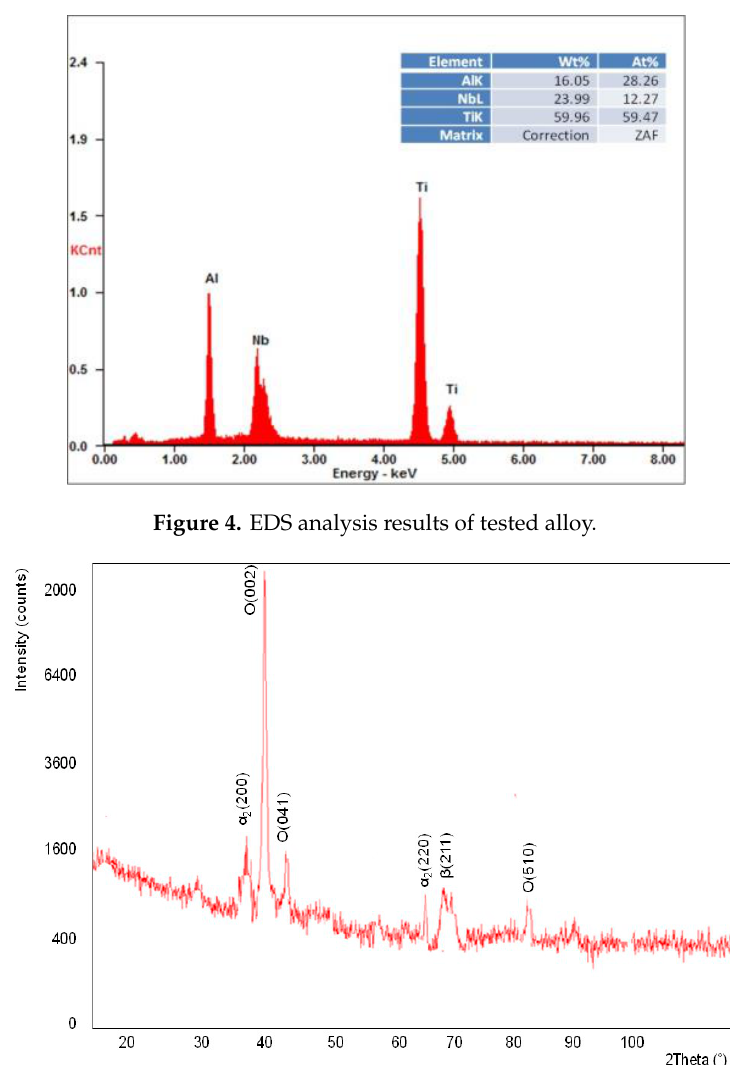
Figure 5. XRD analysis result of tested alloy.